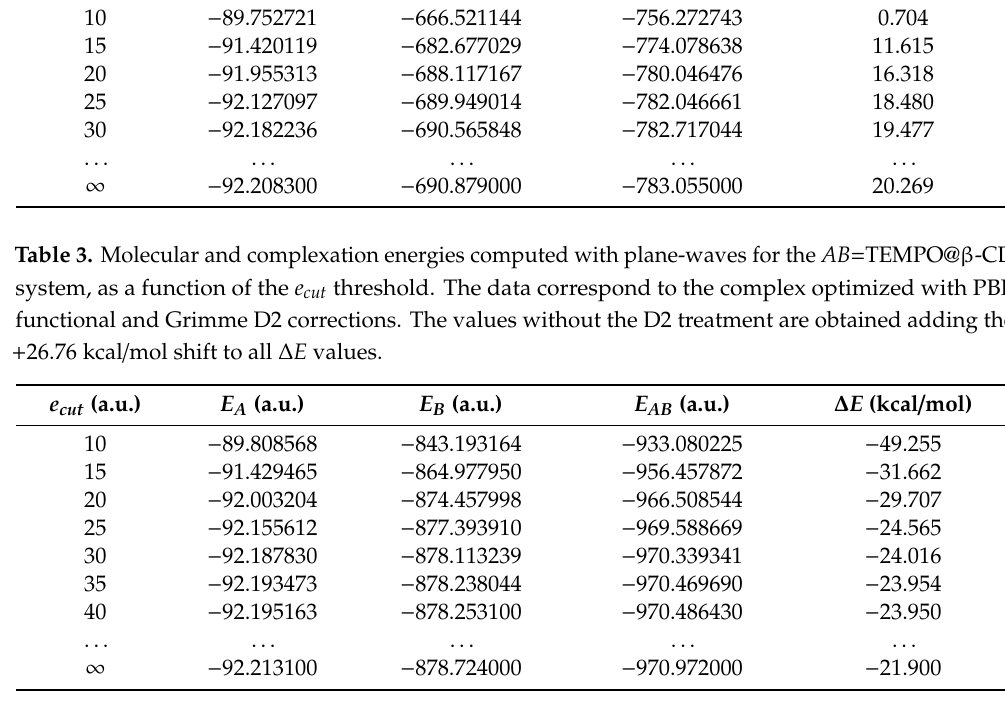
Table 2. Molecular and complexation energies computed with plane-waves for the AB = TEMPO@CB[6] system, as function of the e cut threshold, parallel with the accuracy of the basis set. The data correspond to the complex optimized with PBE functional and Grimme D2 corrections. The values without the D2 treatment are obtained adding the + 63.17 kcal / mol shift to all ∆ E values. e cut (a.u.)